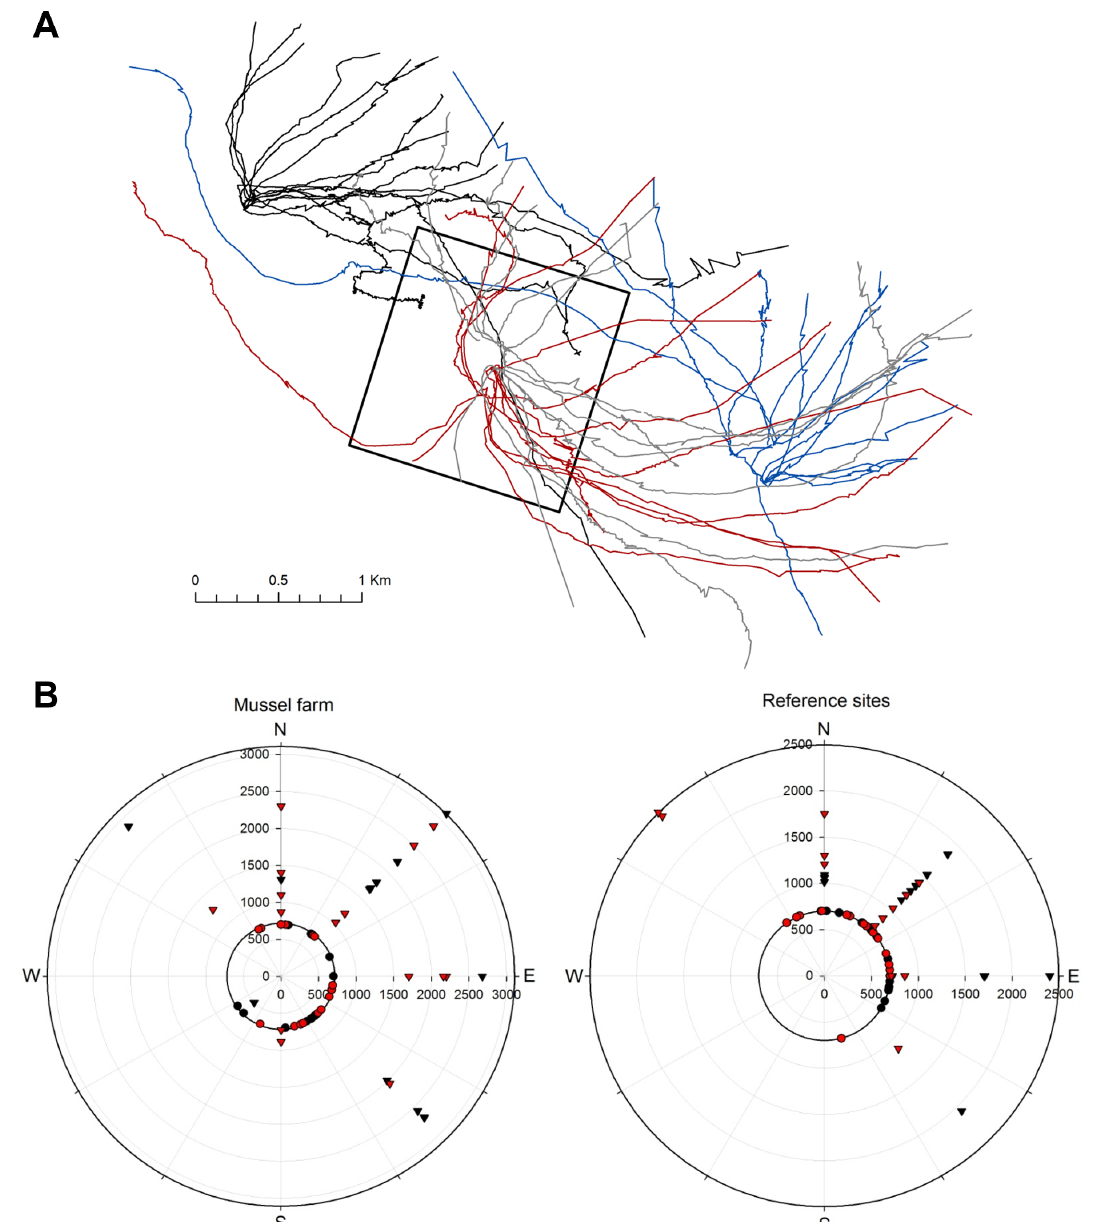
Fig. 2. (A) Raw movement data and (B) circular scatter diagrams representing the direction and distance traveled by 60 lob- sters during the acclimation period (i.e. 24 h post-release) in the monitored area in 2014. (A) Movement tracks by lobsters col- lected from and returned to the east (black lines), west (blue lines), and farm (red lines) arrays; also depicted are lobsters col- lected from outside of the farm site but placed in the farm post-tagging (grey lines). (B) The inner circle (700 m radius) corresponds to the area covered by the mussel farm (and equivalent area in the reference sites), which is roughly equivalent to the distance between receiver arrays. Circles represent the direction of lobster movements within the farm (or equivalent ref- erence sites) and triangles represent the direction of lobster movements outside of these sites. In reference area sites, black and red symbols represent lobsters in west and east reference sites, respectively. In the farm site, black and red symbols represent lobsters caught inside and outside of the mussel farm, and 51 d in 2014 and 2017, respectively (Fig. 4). Of